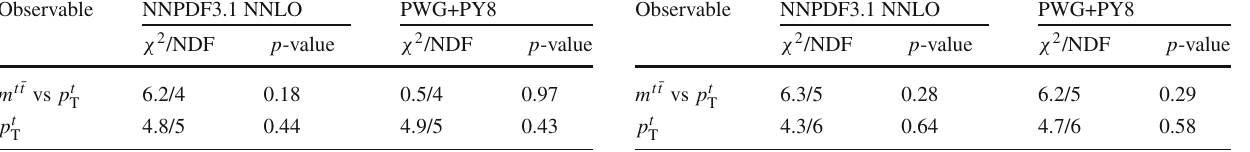
calculated using the covariance matrix of the measured spectrum. The NDF is equal to the number of bins in the distribution